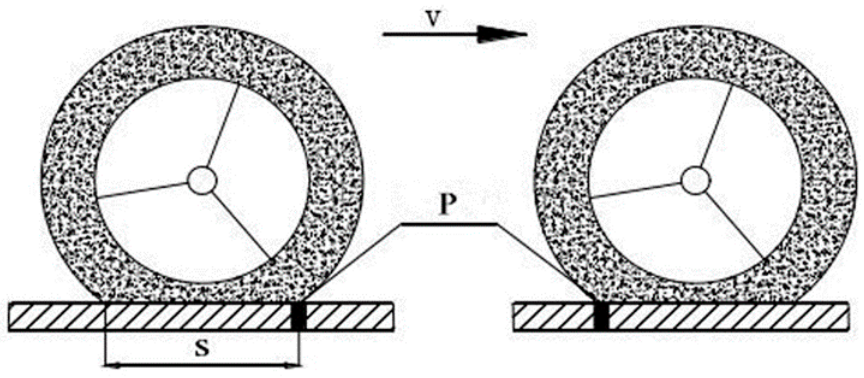
Figure 1. Schematic diagram of a tire passing through a road section p.